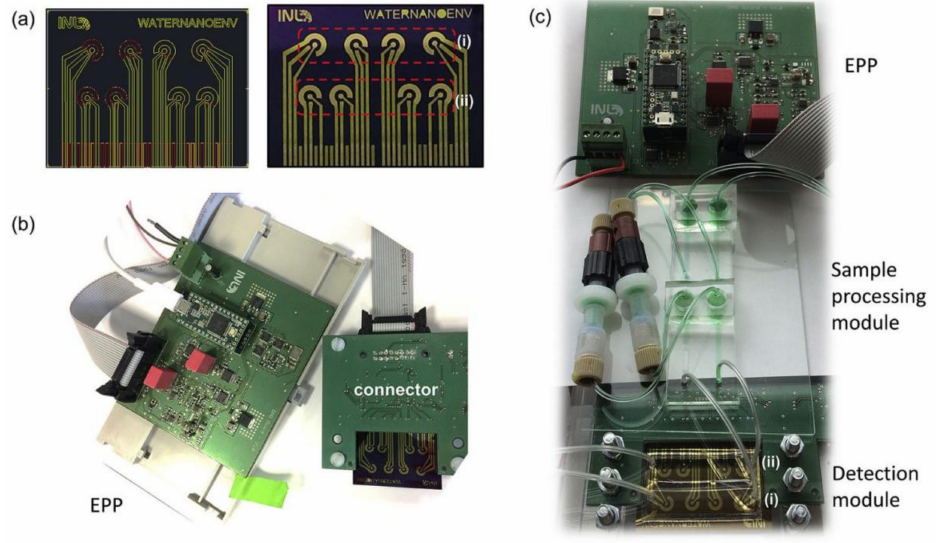
Figure 6. ( a ) Design and fabrication of electrochemical-cell-chips development; ( b ) electrochemical impedance portable platform for EIS measurements; and ( c ) complete portable system for automatic detection (reproduced with the permission of